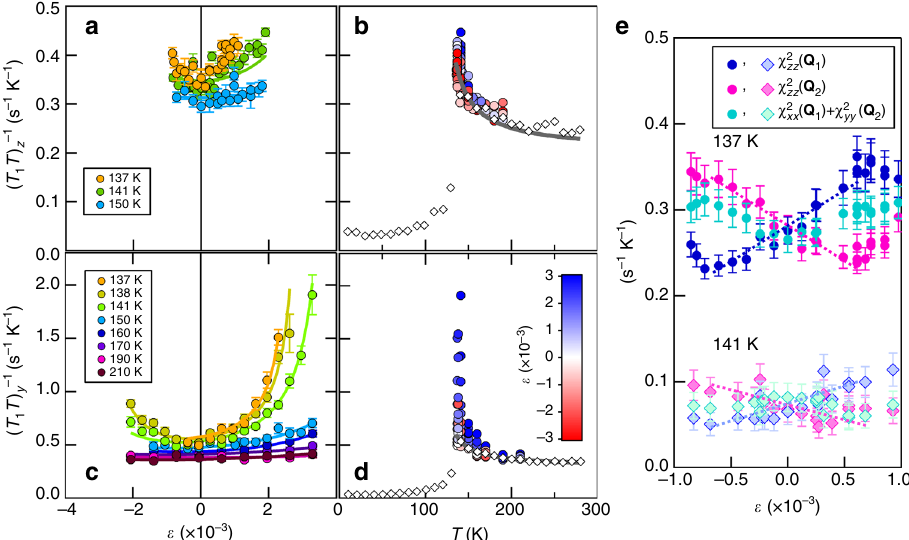
vs. strain ( a , c ) and vs. temperature ( b , d ). The solid lines are fi ts as Fig. 2 Strain and temperature dependence of the spin-lattice relaxation rate. ð T 1 T Þ (cid:3) 1 y ; z described in the text, and error bars are determined from least squared fi tting as described under Methods. The open diamonds in b , d are reproduced from ref. 32 . e χ z z ( Q 1 ), χ z z ( Q 2 ), and χ x x ( Q 1 ) + χ y y ( Q 2 ) as a function of strain at 137 K and 141 K. The data have been displaced vertically for clarity. The dashed lines are guides to the eye, and the error bars are determined by propagating the errors in a – d material. A free-standing NMR coil was placed around the sample prior to securing the ends of the crystal in the strain device with epoxy. The radiofrequency fi eld H 1 is oriented parallel to the strain axis, which is always perpendicular to the external fi eld, H 0 . In our device, strain is always applied along the x -axis de fi ned in Fig. 1; since the b -axis is de fi ned as the shorter axis, positive (i.e., tensile) strain corresponds to x k a and y k b , whereas negative (i.e., compressive) strain gives y k a and x k b . When the crystal is strained by applying voltage to the piezoelectric stacks, the displacement, x , is measured by a capacitive dilatometer, and strain is calculated as ε = ( x − x 0 ) / L 0 , where L 0 is the unstrained length of the crystal. To account for differential thermal contraction, the zero-strain displacement, x 0 , was determined by the condition that the quadrupolar splitting ν αα satis fi es the tetragonal-symmetry | ν xx | = | ν yy | = | ν zz | / 2, as